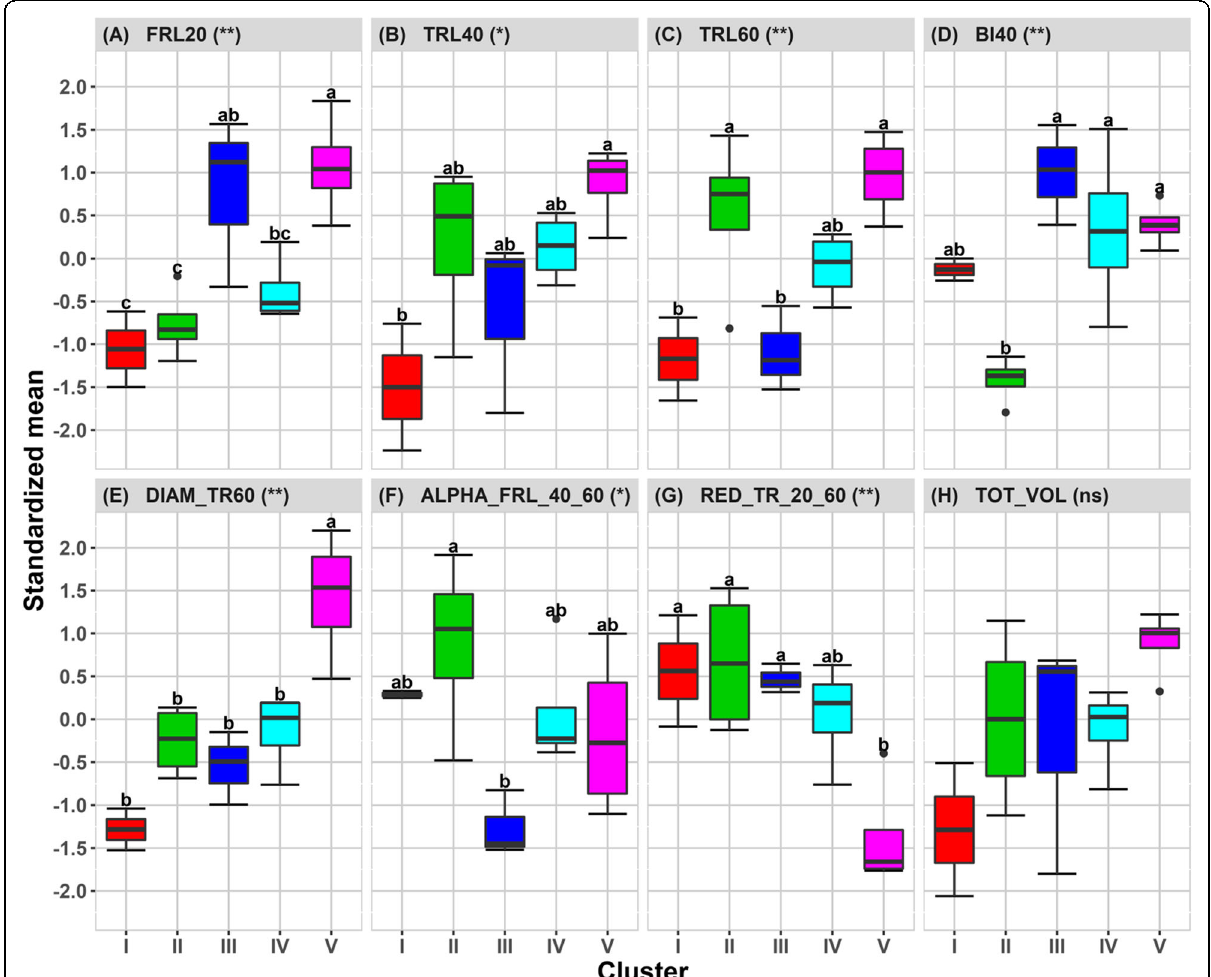
Fig. 2 Box-plots of the standardized means of the eight selected root traits among the 17 accessions gathered in 5 clusters under irrigated conditions. The symbol in brackets indicates the cluster effect (** significant at 1%, * significant at 5% and ns not significant ). The averages followed by the same letter do not differ statistically according to the Tukey test (p-value